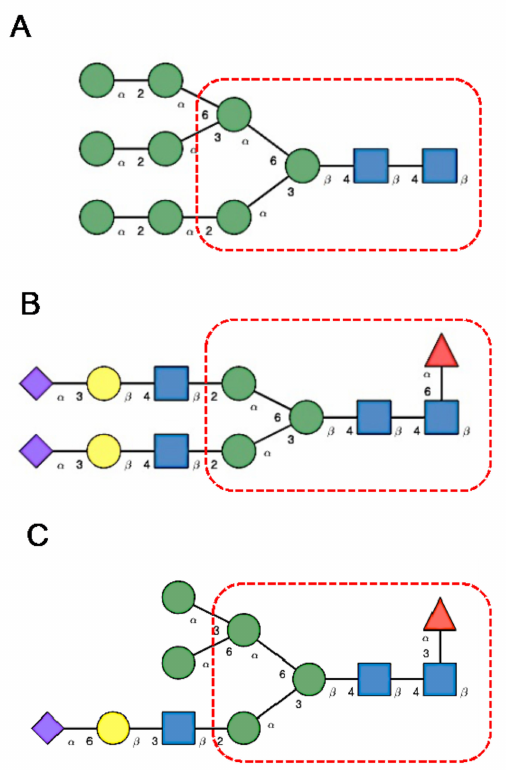
Figure 6. ( A ). High-mannose N -glycan, in which only Man (green circles) residues extend the core. ( B ). Complex N -glycans with two antennae initiated by a GlcNAc residue (blue square) extending the core. ( C ). Hybrid N -glycan with Man extending the Man1,6 arm of the core and GlcNAc extending the Man1,3 arm of the core. The core is delineated by a dashed red line.